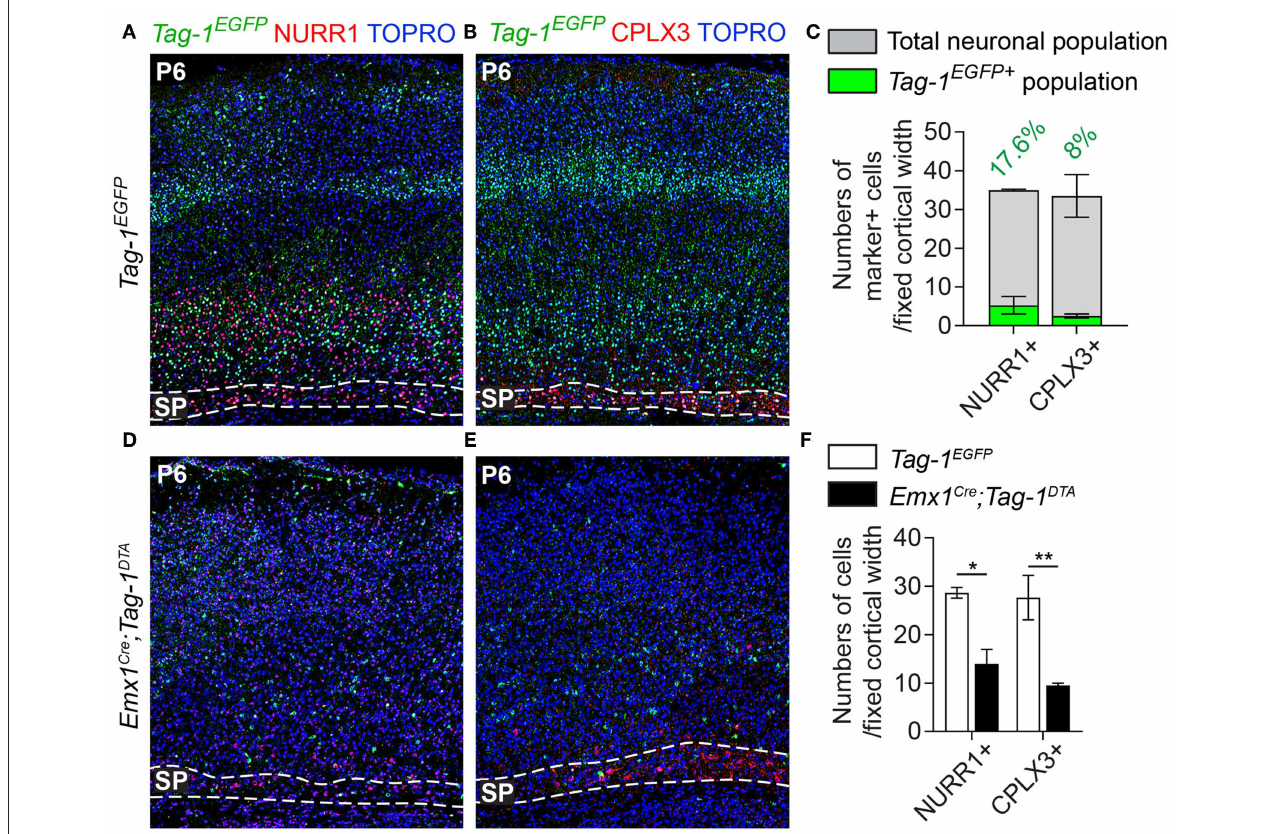
FIGURE 7 | Targeted ablation of TAG-1 + cortical neurons results in reduced cells of the postnatal subplate. (A,B,D,E) Immunofluorescent analysis of Tag-1 EGFP , NURR1, and CPLX3 at P6 in Tag-1 EGFP and Emx1 Cre ;Tag-1 DTA mice shows a detectable subplate at the somatosensory cortex. (C) Quantification of the contribution of Tag-1 EGFP + cells in the control subplate of the somatosensory cortex at P6. Data are plotted as mean ± SEM, N = 2. (F) Quantification of the cells of subplate in Tag-1 EGFP and Emx1 Cre ;Tag-1 DTA mice at P6 using the markers NURR1 and CPLX3. Data are plotted as mean ± SEM, N = 2. For NURR1 + cells, P = 0.019 and for CPLX3 + cells, P = 0.007. * p < 0.05, ** p <